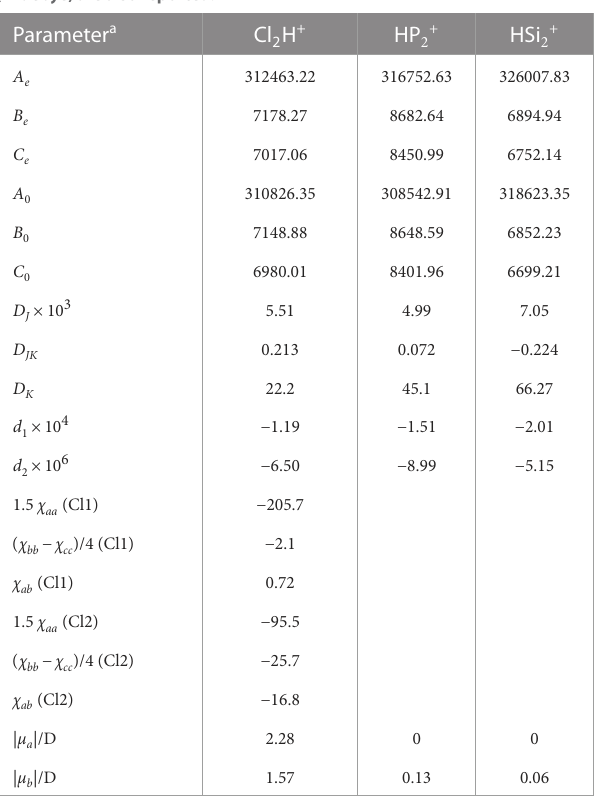
TABLE2 Rotationalparameters(inMHz)ofWatson’s S reducedHamiltonian ( I r representation)forCl 2 H + , HP 2 + ,and HSi 2 + .Dipolemomentcomponents